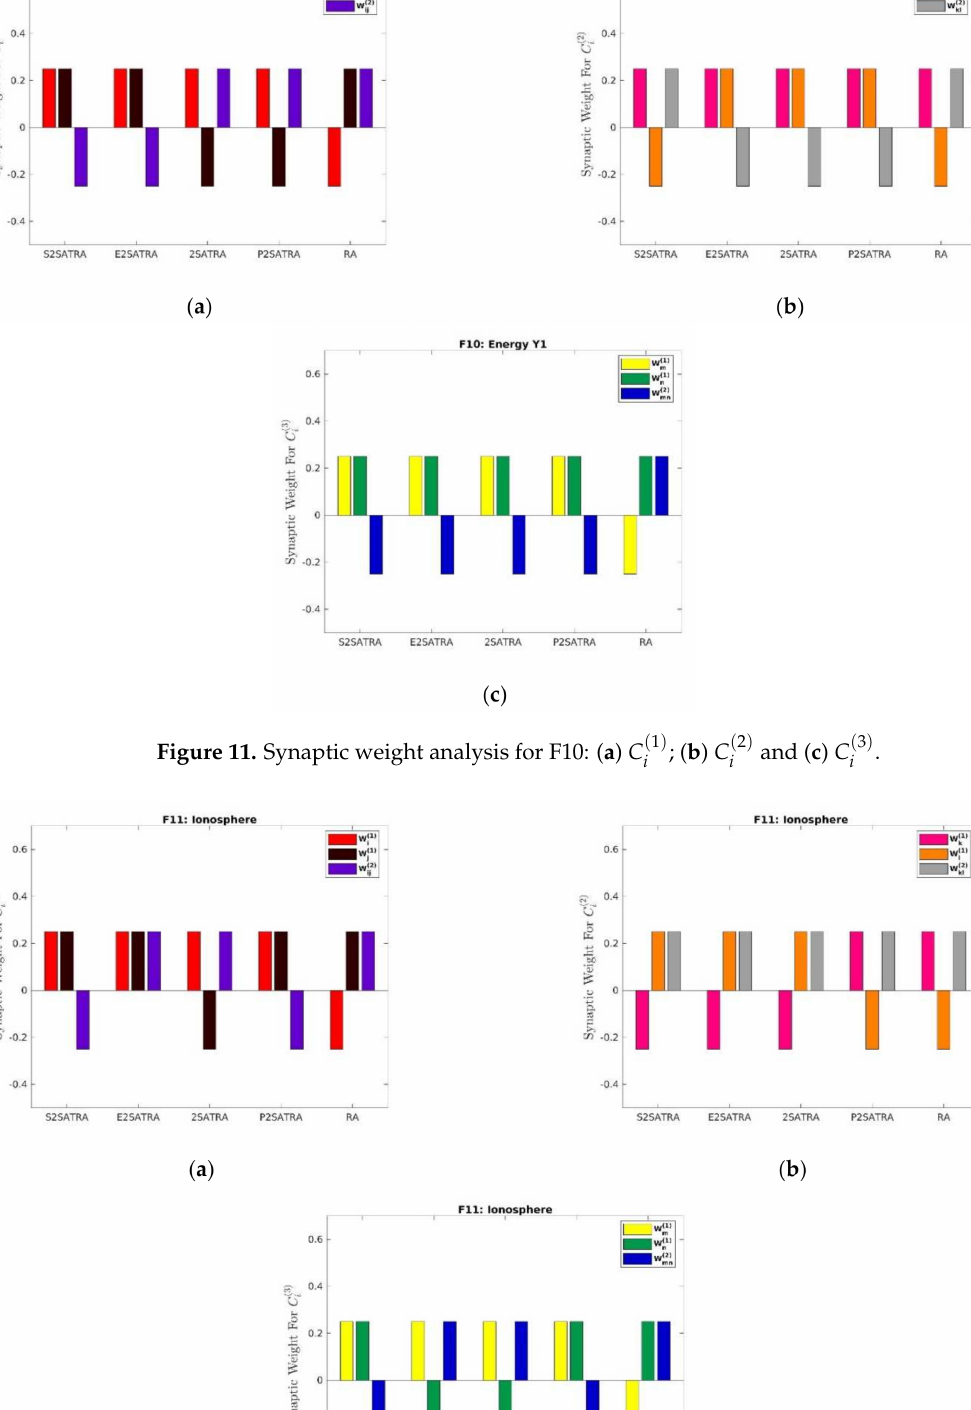
( 1 ) ( 2 ) ; ( b ) C and ( c ) C i i